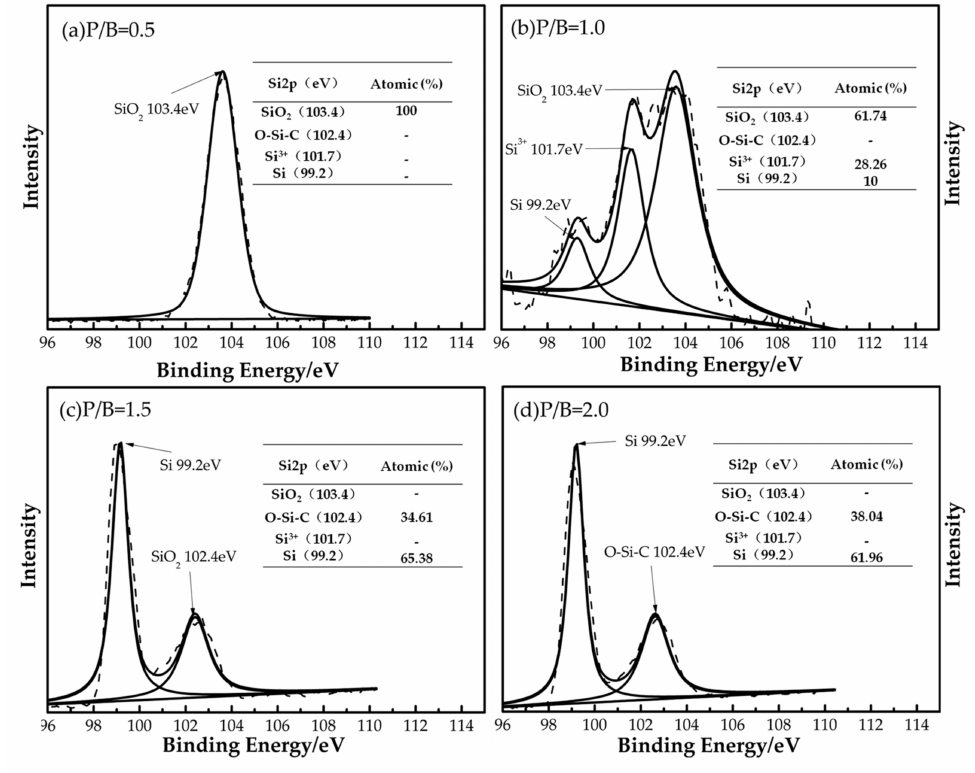
Figure 4. X-ray photoelectron spectroscopy (XPS) spectra in the Si2 p region for polysiloxane/Al